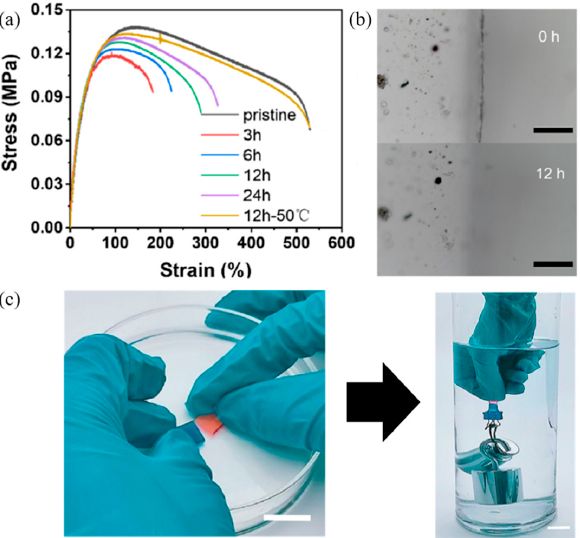
Figure 21. The experimental part of the self-healing process of fluorinated elastomer; ( a ) stress–strain curves of pristine and healed samples with various healing times, ( b ) optical images of healed samples after healing time for 12 h at 25 °C underwater, and ( c ) experimental part of the healed sample using lifting a weight underwater [110]. Adapted with permission from [110]. Copyright 2020 American Chemical Society.